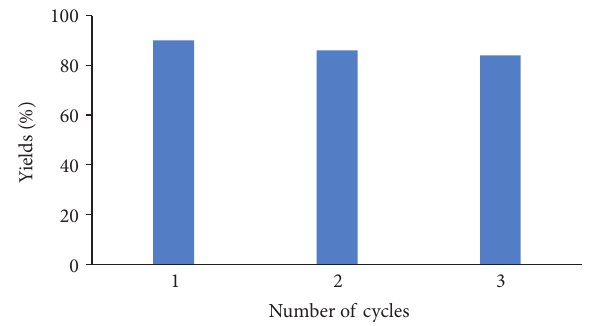
F 1: Recyclability of NiO